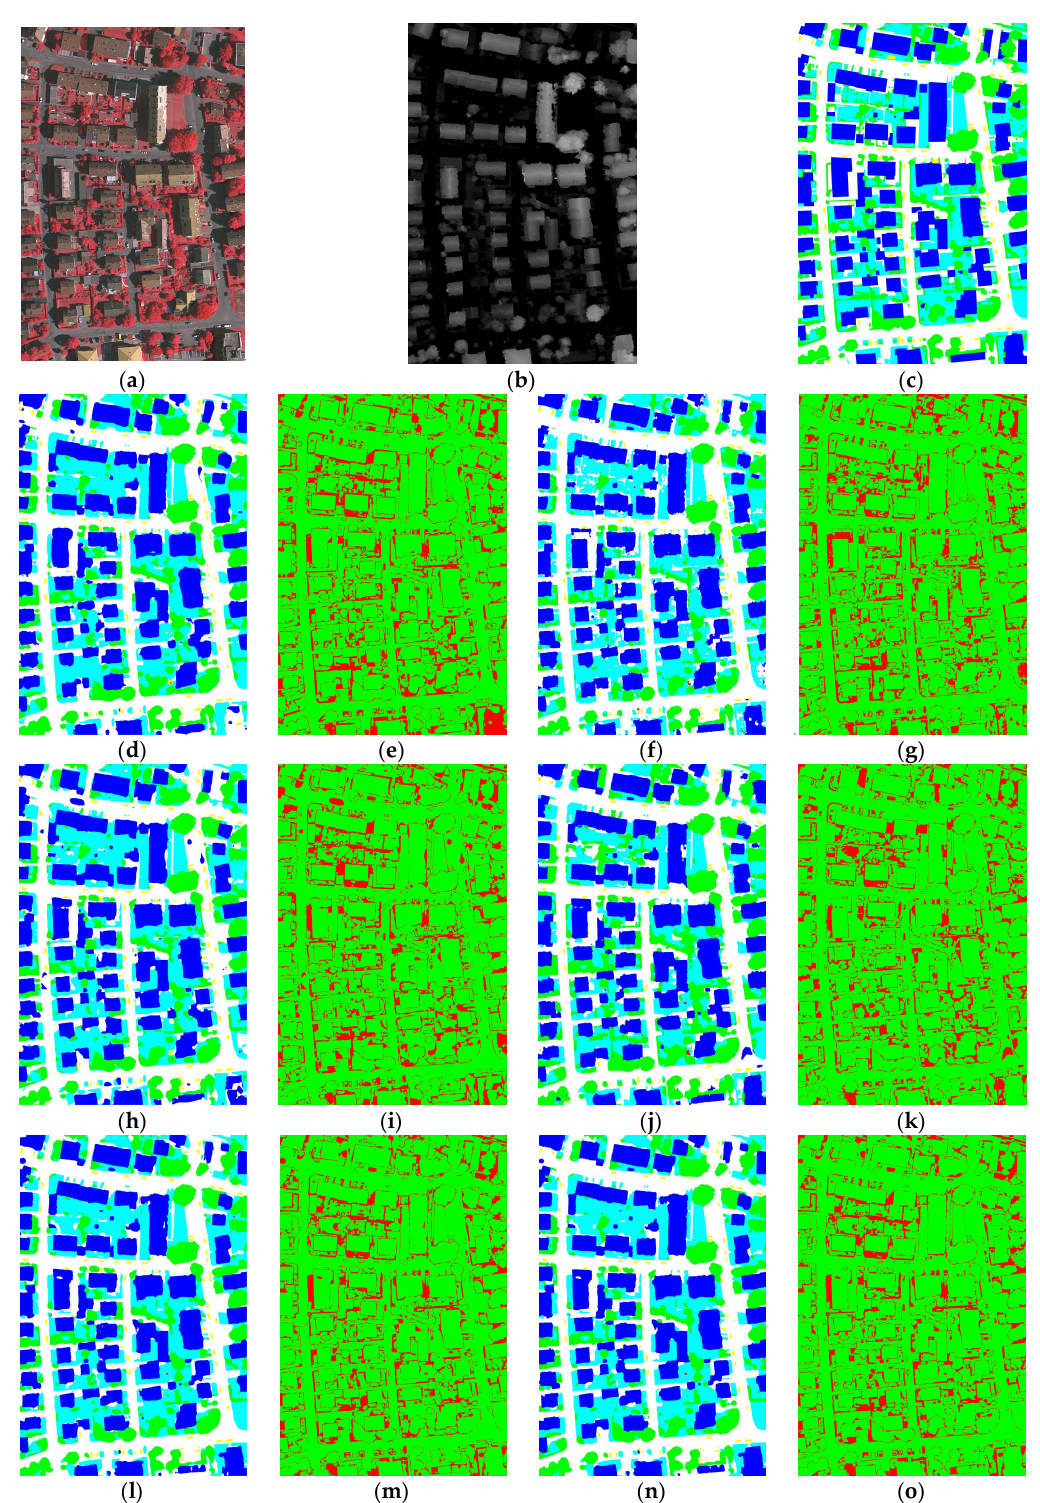
Figure A5. Full tile prediction for NO. 3 of Vaihingen dataset. Classes: impervious surface (white); buildings (blue); low vegetation (cyan); tree (green); car (yellow); clutter (red). ( a ) TOP, true orthophoto; ( b ) nDSM, normalized DSM; ( c ) GT, ground truth; ( d , e ) inference result and Red/Green Image of FCN-8s; ( f , g ) inference result and Red/Green Image of SegNet; ( h , i ) inference result and Red/Green Image of FSN-noL; ( j , k ) inference result and Red/Green Image of HSN; ( l , m ) inference result and Red/Green Image of FSN; and ( n , o ) inference result and Red/Green Image of FSN + CRFs.